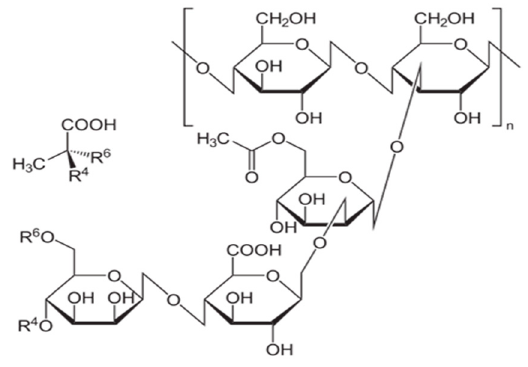
Figure 3. Molecular structure of xanthan gum .